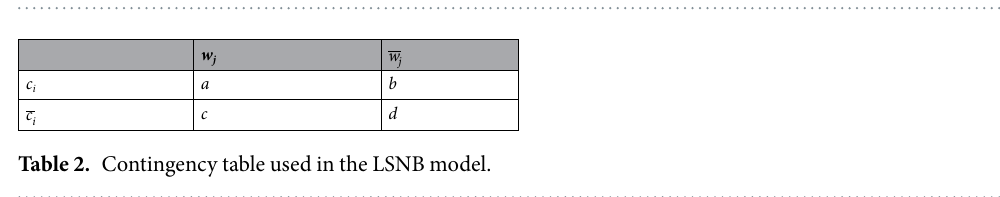
Figure 1. ( a ) Relation between | LS q p ( ) and | LS p q ( ) . ( b ) Relation between | LS q p ( ) and | LS q p ( ) .